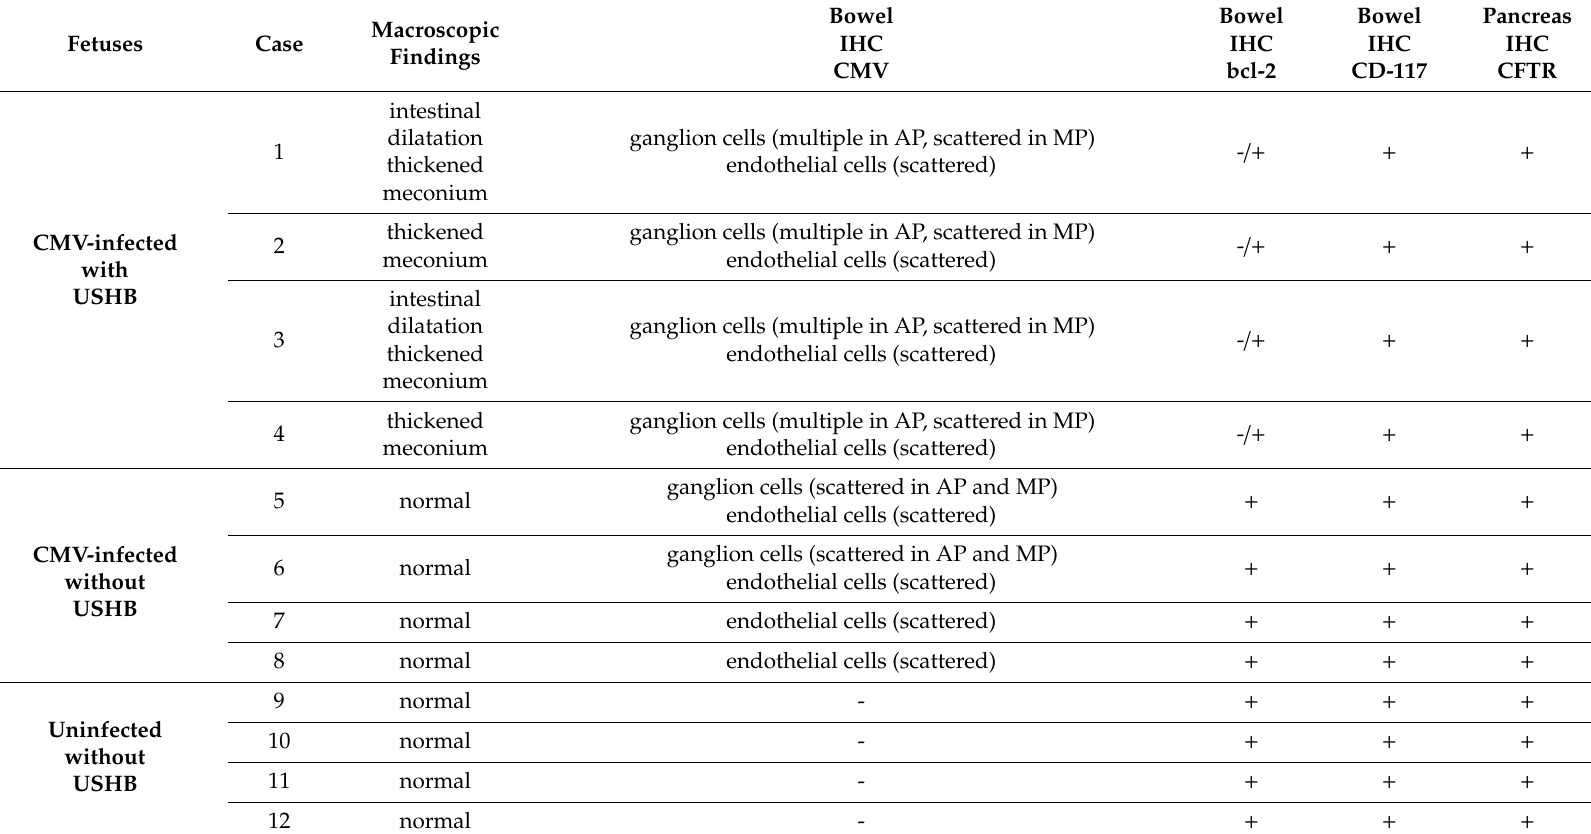
Table 2. Autopsy findings in the 3 groups